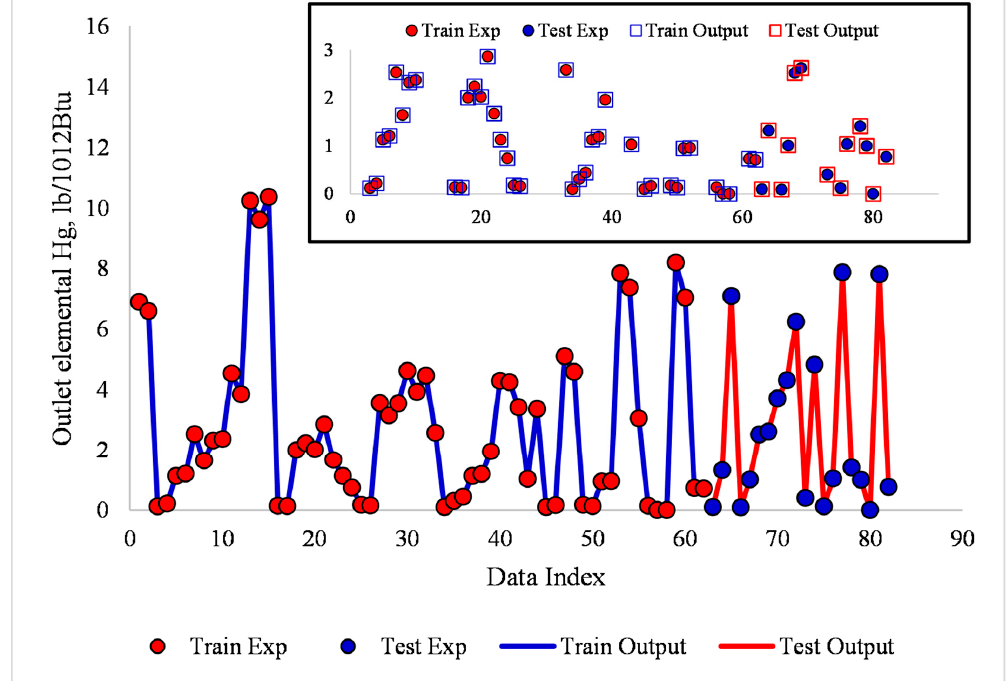
Figure 5. Obtained data from the plants and the ANFIS values for mercury emissions during the stages of training and testing. Mathematics 2019 , 7 , x FOR PEER REVIEW